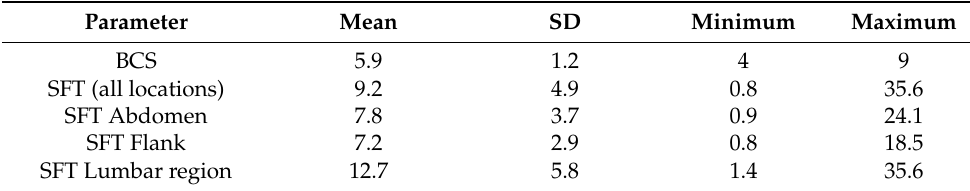
Table 1. Description of adiposity parameters in study population ( n = 88 Labradors).